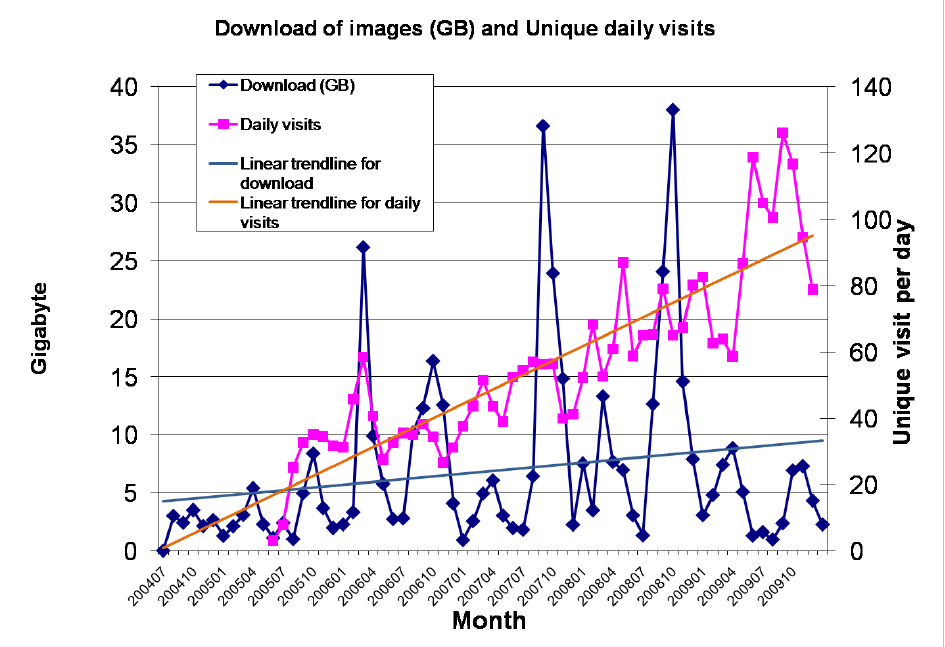
Figure 4. Unique daily visits averaged monthly and total downloads of DNGP images in Gigabytes between July 2004 and December